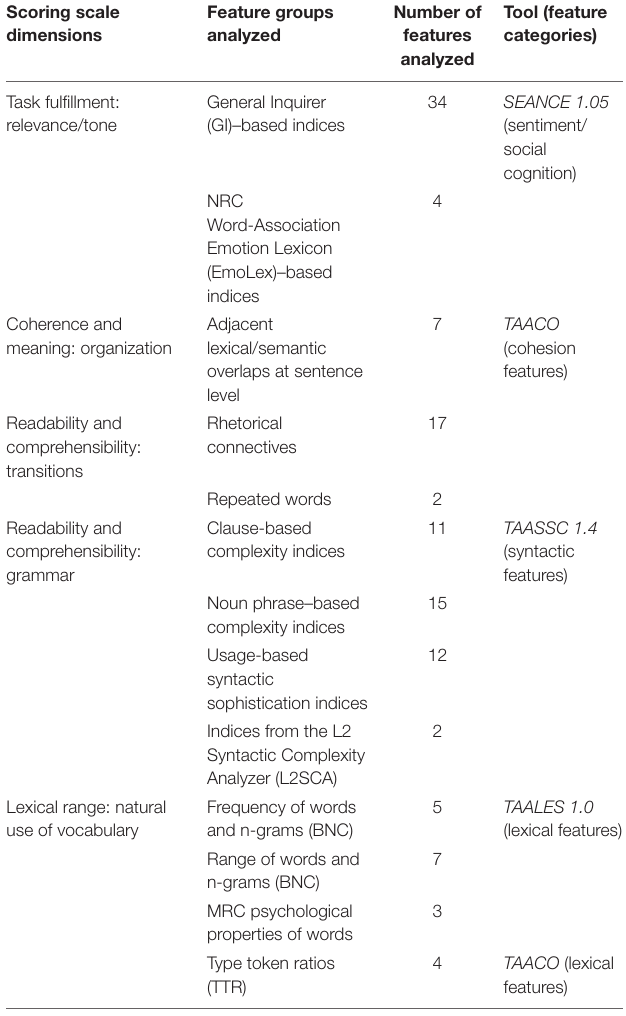
TABLE 2 | Summary of analytical tools and relevance of the linguistic features to the CELPIP-General scoring